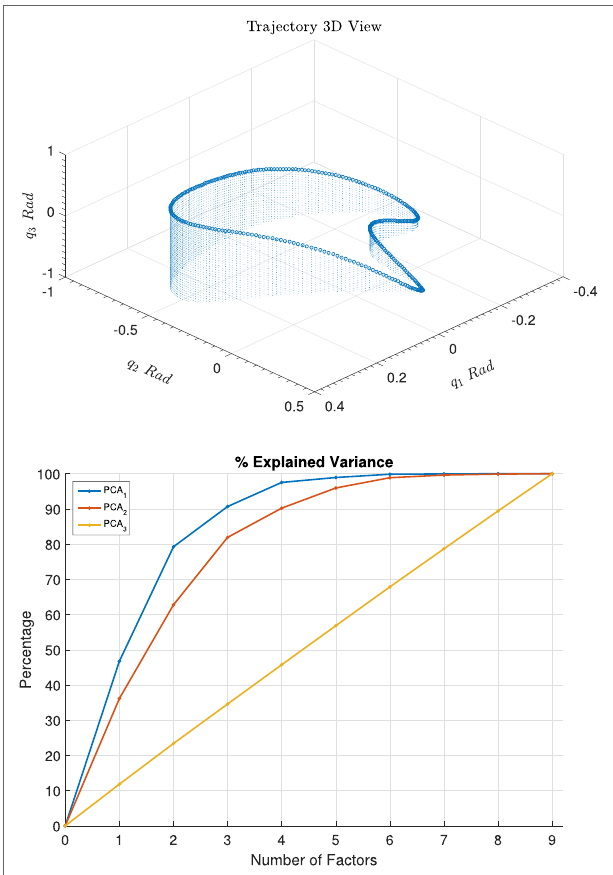
FIGURE 5 | PCA results comparison between input ( PCA 1 ), lack-of-fit residuals ( PCA 2 ) and a random signal ( PCA 3 ) for cyclic trajectory.